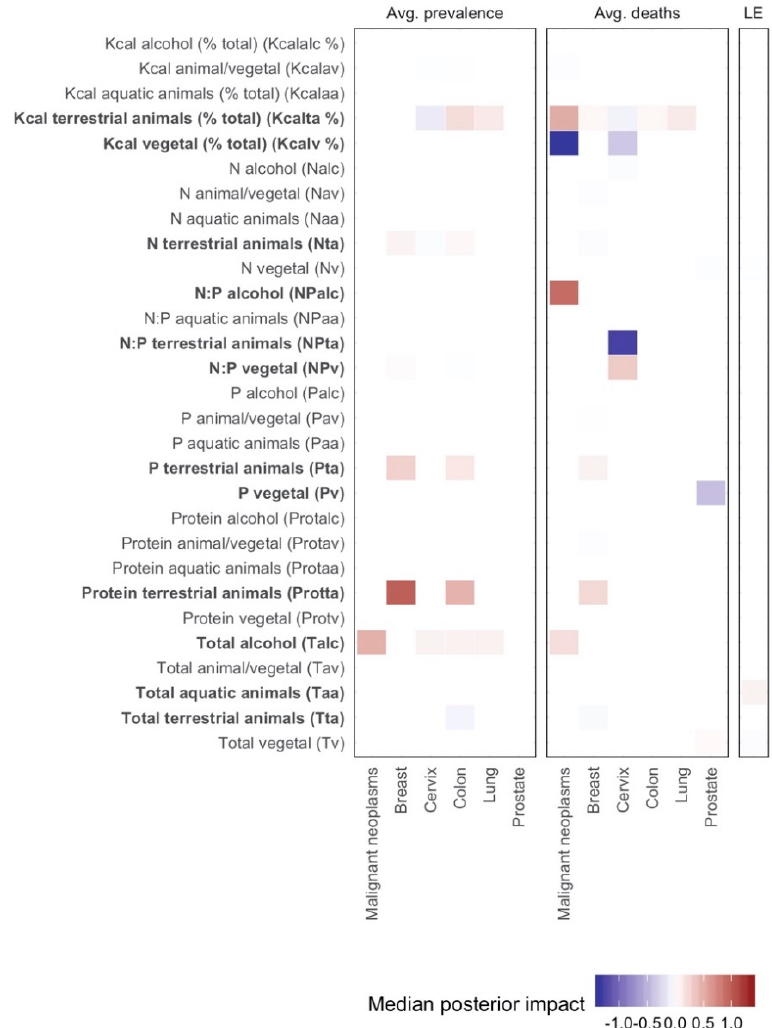
Figure 1. Median posterior coefficient estimates from the Bayesian econometric models. Each panel corresponds to datasets (for prevalence, deaths and LE—life expectancy; the shading indicates the magnitude of the posterior impact. Not significant estimates under 95% confidence intervals are shaded in white. Results are based on three eigenvectors associated with the highest eigenvalues of each cluster (Supplementary Table S1). Predictors discussed in the text are denoted in bold.